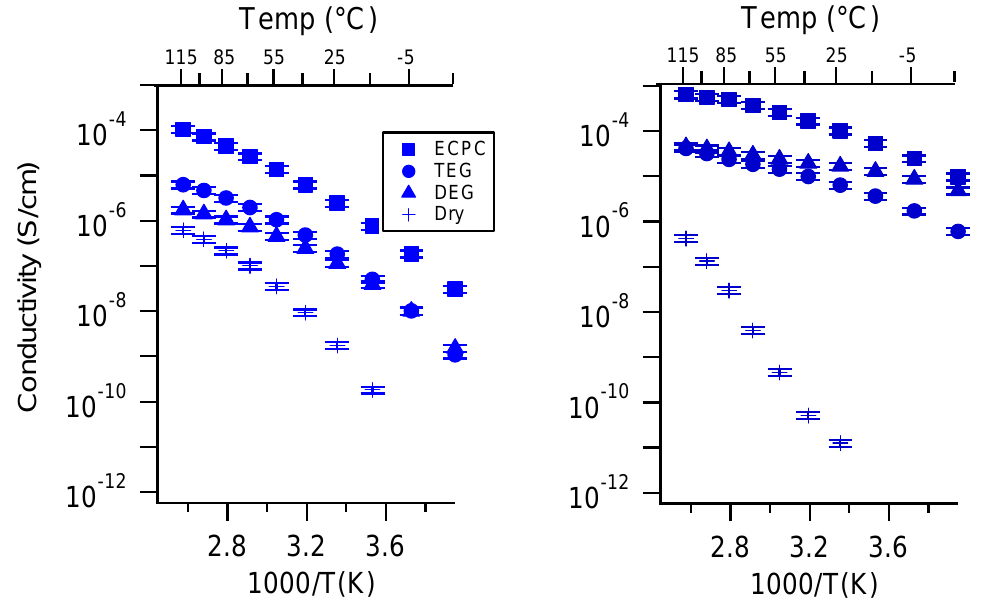
Figure A25. Conductivity as a function of solvent for PEGDMA1000_low_SSNa (left) and PTHFDA1000_low_STFSINa (right) SIPEs. Temperatures ranged from − 20 °C to 115 °C. Note that there may be a non-negligible fraction of electronic conductivity in conditions where conductivity of less than 10 − 9 S/cm is reported.